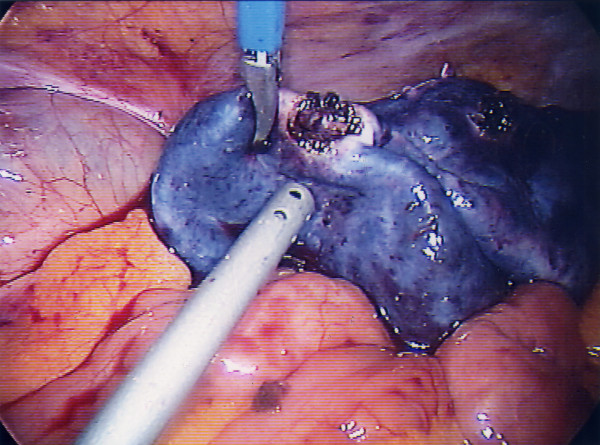
The collapsed cyst.